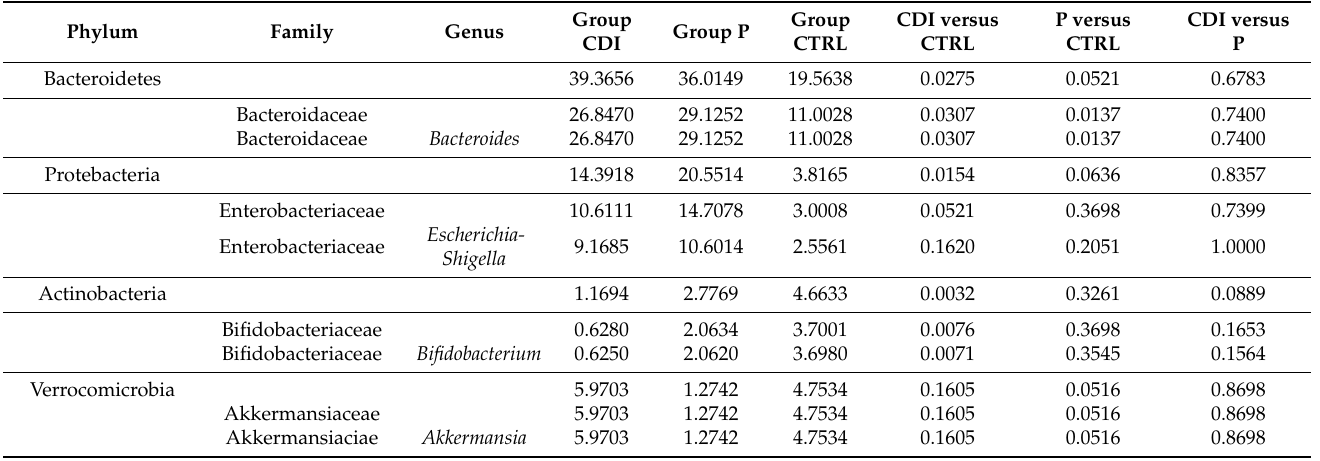
Table 5. Composition analyses of key OTUs in the remaining phyla in the study